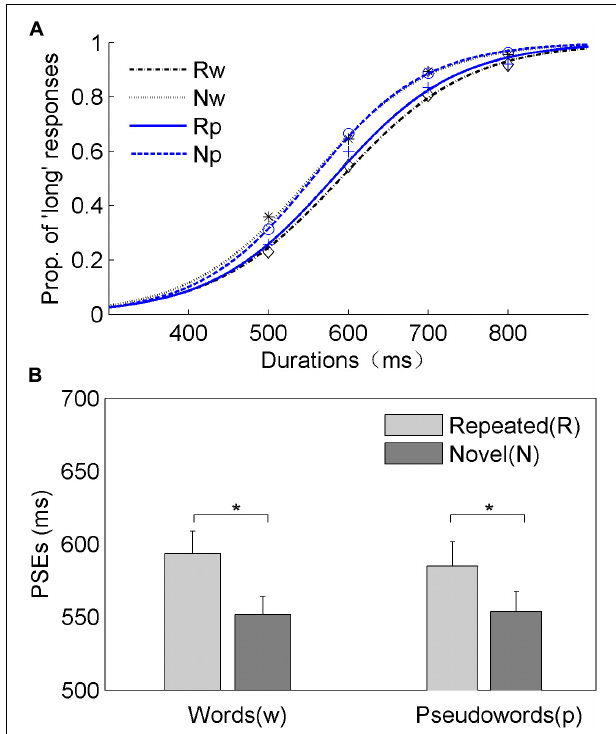
FIGURE 2 | Results of Experiment 1. (A) Mean proportions of “long” responses against the comparison durations plotted with fitted psychometric curves representing the Rw, Nw, Rp, and Np conditions. (B) The mean points of subjective equality (PSEs) and respective standard errors are shown for the four conditions. * p < 0.05.